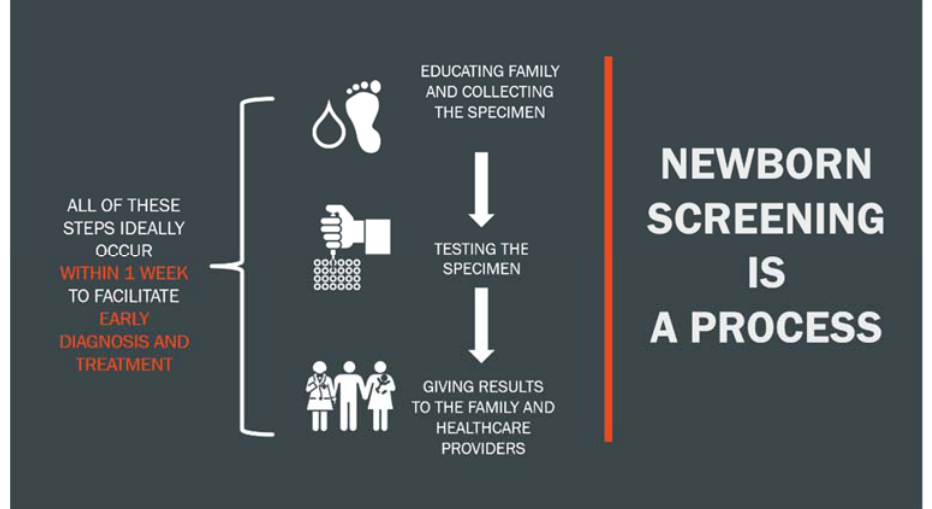
Figure 1. Newborn screening process following a